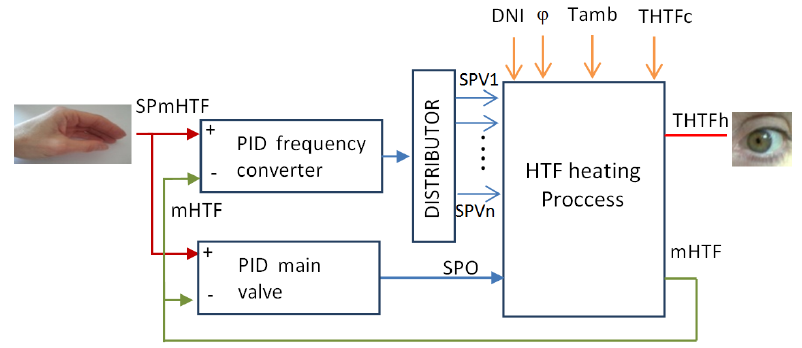
Figure 15. Semiautomatic control of the HTF ‐ heating process.